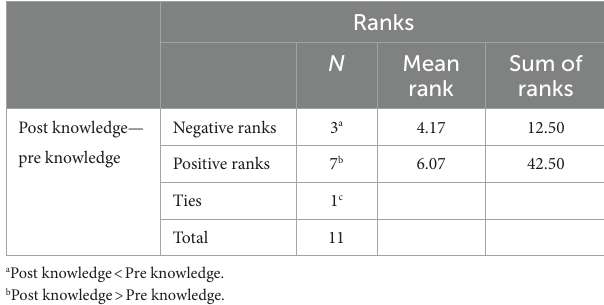
TABLE 2 Negative, positive, and tied paired differences of PST knowledge for self-guided group.